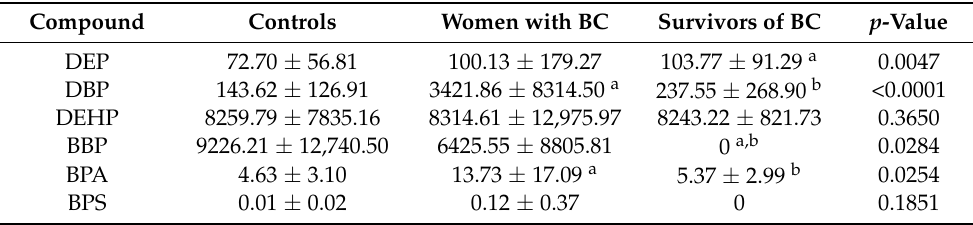
Data represent the average values plus/minus the standard deviation (SD) of each group; a = significant differences between controls, b = significant differences between women with